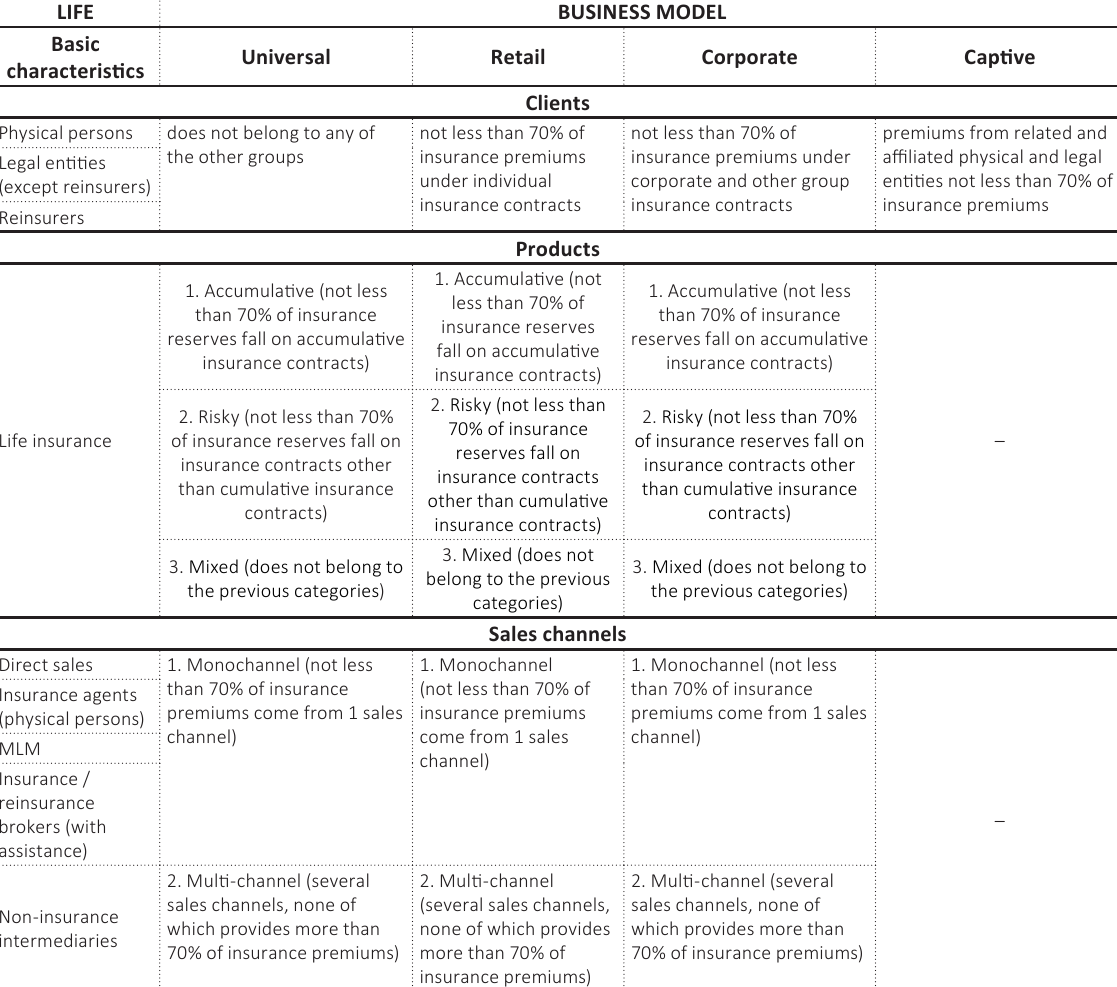
Table 6. Business model of LIFE insurance companies according to the National Bank of Ukraine in